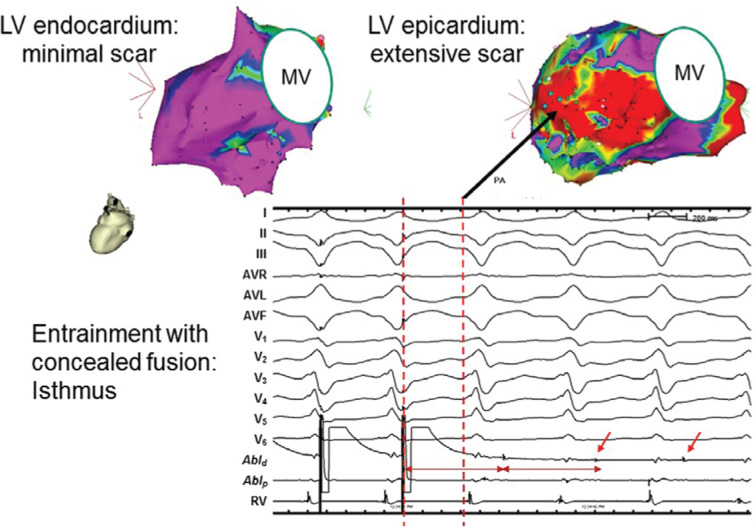
Endoepicardial mapping in patients with NICM. Endocardial and epicardial bipolar electrogram recordings were performed in a patient with NICM. The LV endocardial voltage showed minimal abnormal low-voltage areas, while the LV epicardial voltage showed extensive low-voltage scar located near the basal lateral LV. The endocardial and epicardial bipolar voltage color gradient is depicted. The purple areas represent normal tissue (endocardial amplitude ≥ 1.5 mV or epicardial amplitude > 1.0 mV) whereas dense scar is depicted in red (amplitude < 0.5 mV). The border zone is defined as areas with the color gradient being between red and purple. Activation mapping during sustained VT demonstrated an early, mid-diastolic potential located at the LV lateral epicardium (arrow). Overdrive pacing at this site showed entrainment with concealed fusion, consistent with an epicardial isthmus site. LV: left ventricular; MV: mitral valve; NICM: nonischemic cardiomyopathy; VT: ventricular tachycardia.